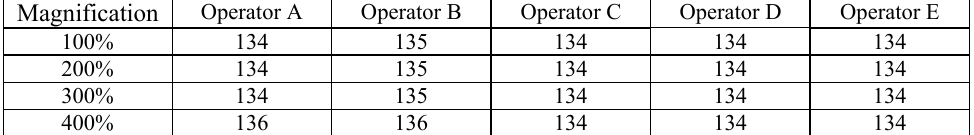
Table 4. Comparison of the measurement result by the operator in measurement of the same length when changing